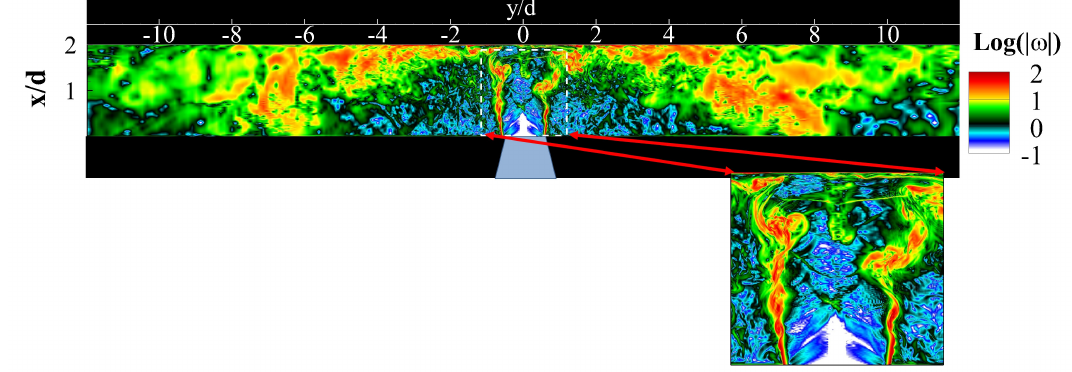
Figure 2. Instantaneous vorticity field visualising the configuration of the supersonic under-expanded impinging jet of this